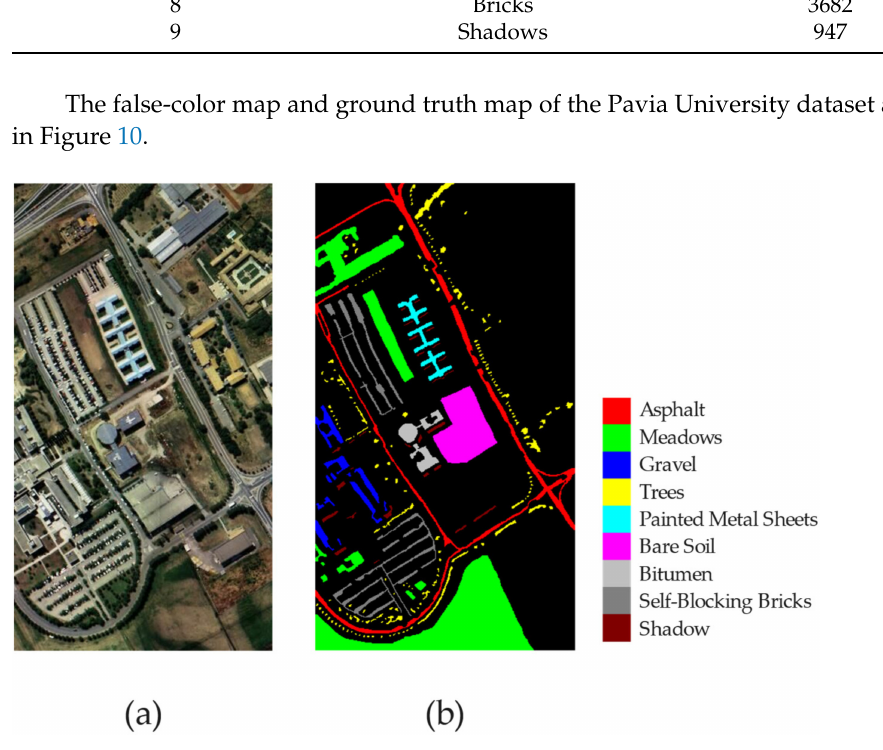
Figure 10. Pavia University dataset: ( a ) false-color map, ( b ) ground truth